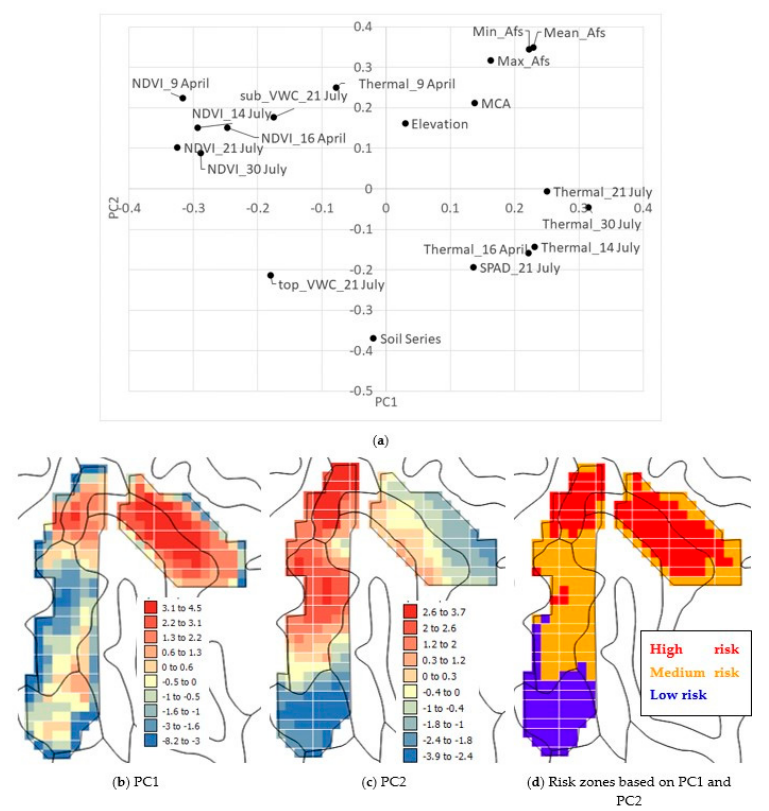
Figure 8. ( a ) PCA plot of 2010 soil and remotely sensed variables in terms of PC1 and PC2 which account for 51% of variation in the data set. Plots of PC1 ( b ) and PC2 scores ( c ) on a 30 m grid and ( d ) a classification based on soil and sensed data for 2010. Black lines show soil series boundaries. Figure 8b and c show the PC1 and PC2 scores of each of the 296 sampling points.